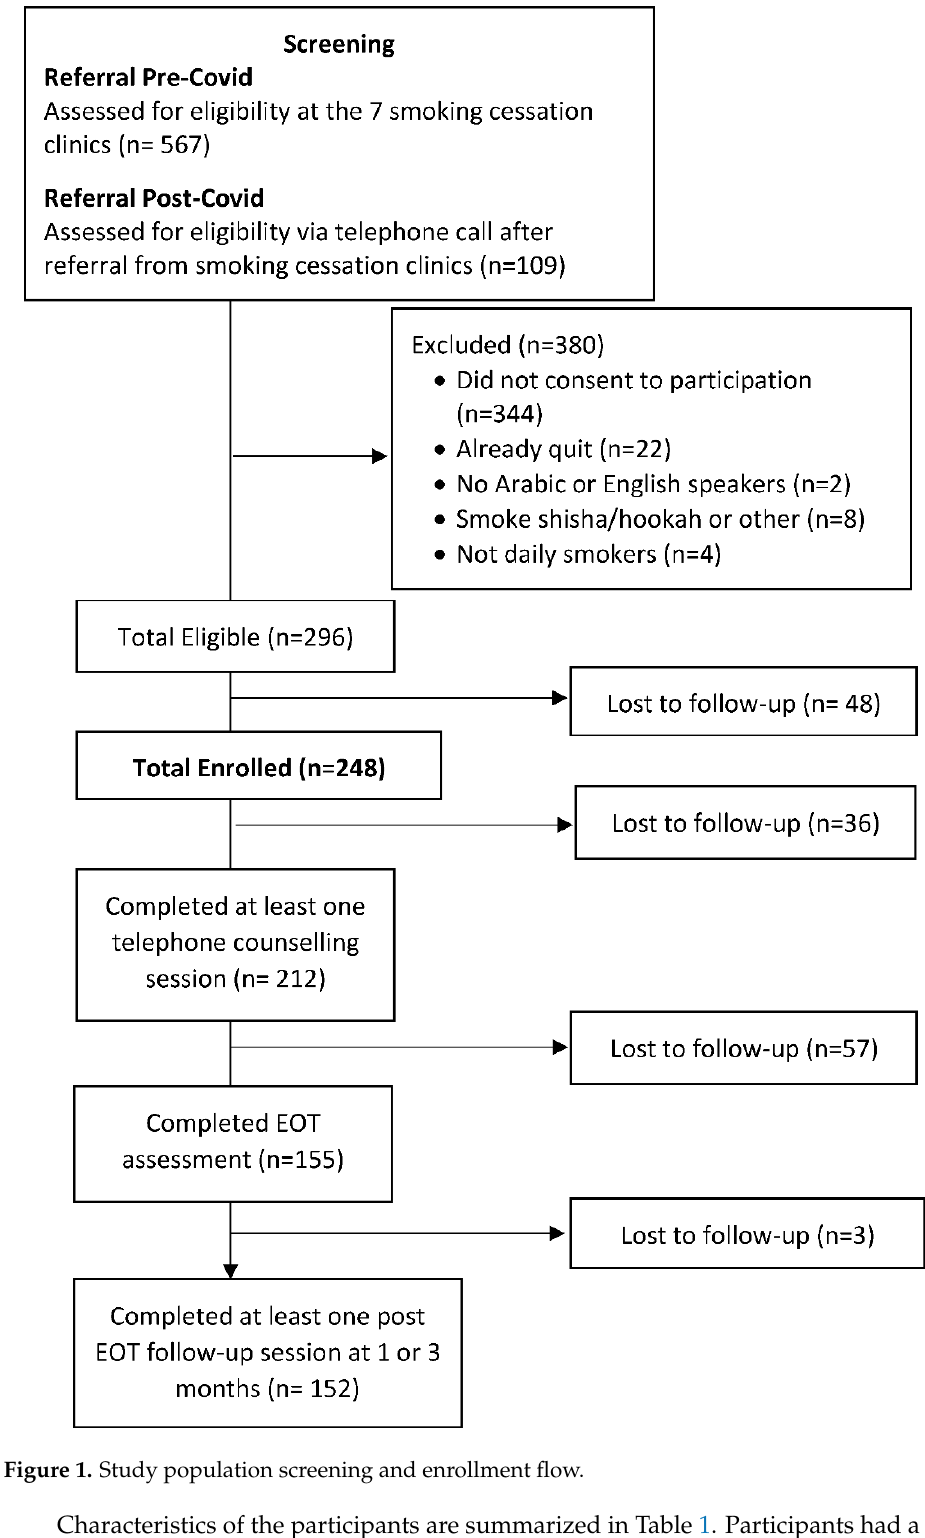
Figure 1. Study population screening and enrollment flow.